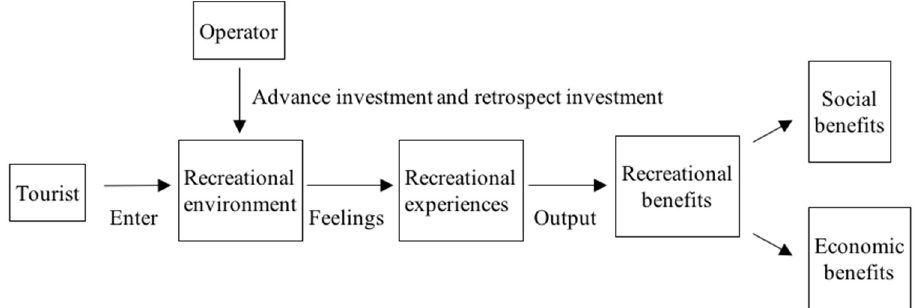
Figure 1. Generation of recreation benefits.